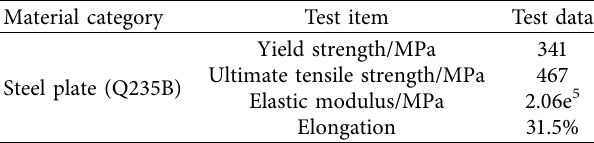
Table 2: Mechanical parameters of steel plate.